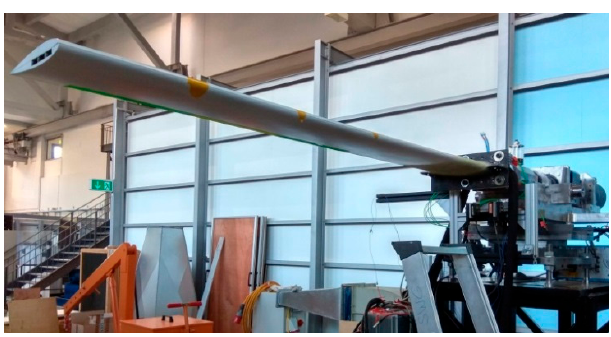
Figure 19. Model mounted on test stand outside the tunnel.